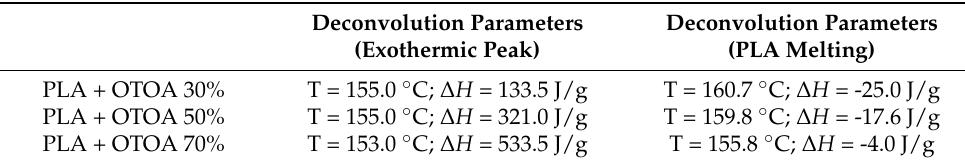
Table 3. Results of the deconvolution of the overlapping calorimetric peaks for PLA films with high OTOA